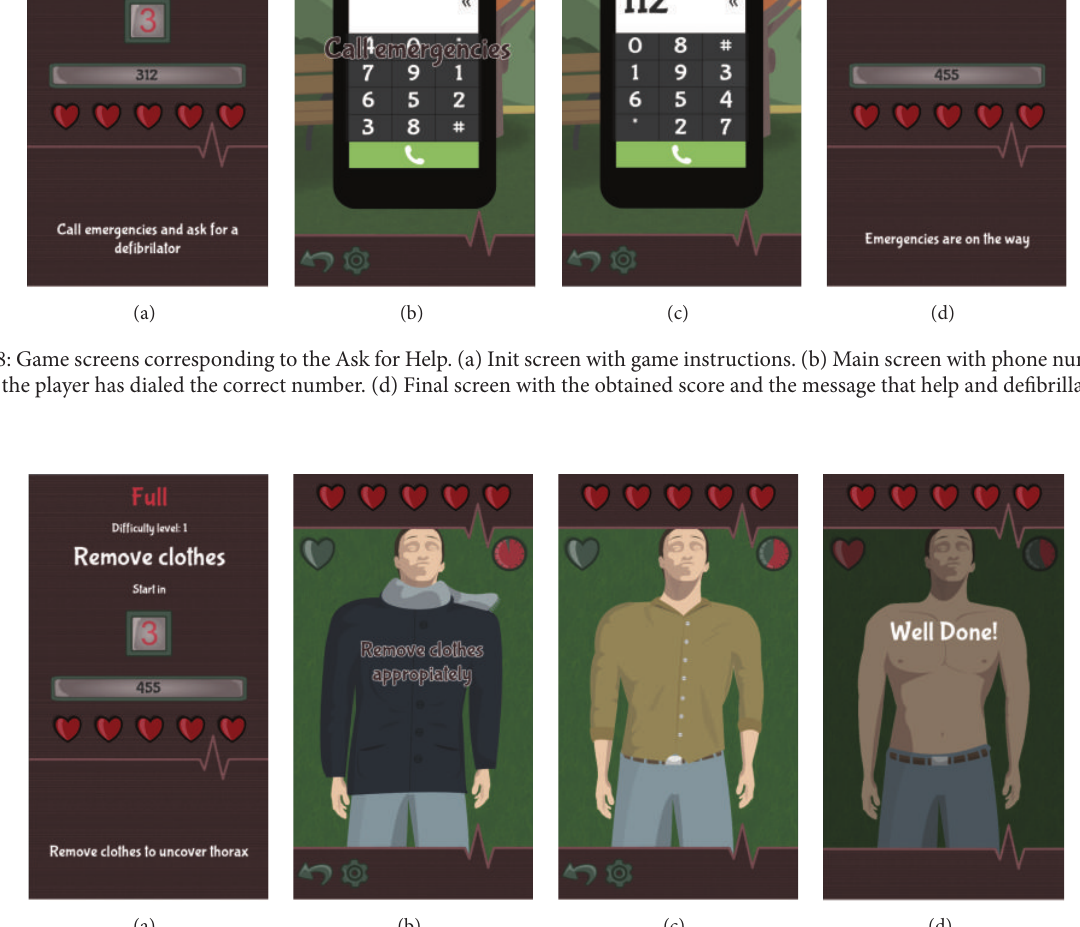
Figure 8 corresponds to the Call Emergencies mini game.